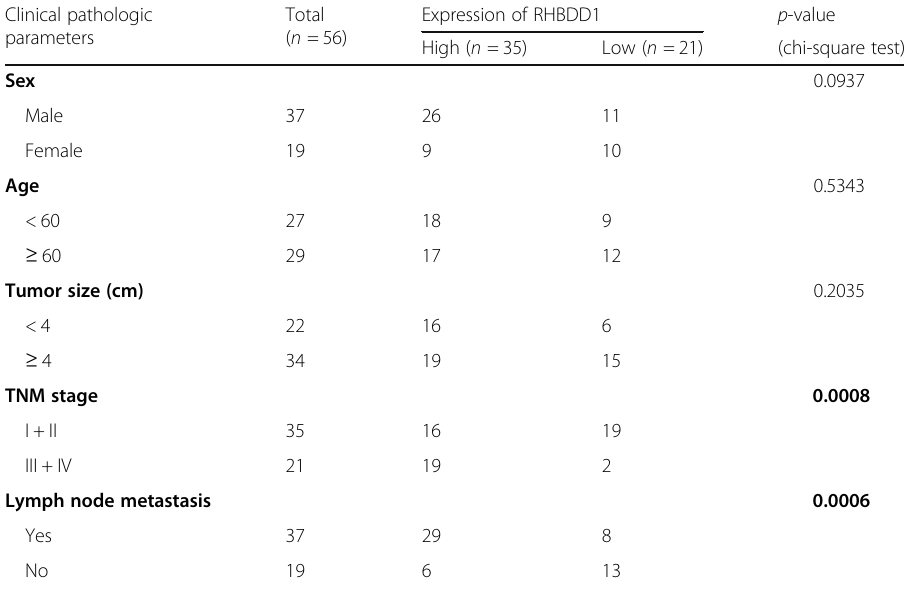
Table 1 Association of RHBDD1 expression with clinicopathologic parameters of NSCLC patients Clinical pathologic